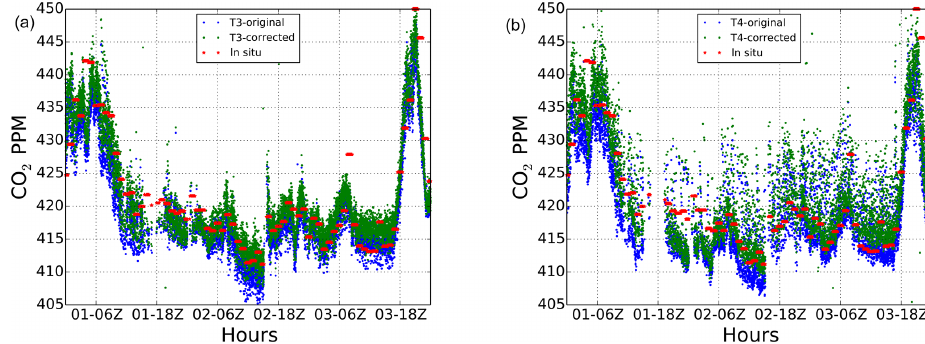
Figure 5. Sample set of 4d median post-processed retrieved GreenLITE ™ values and corresponding in situ observations for a representative 3d period in March 2016. The median values were computed every 6h using a 4d window over all chords for all transceiver–RT-model combinations. The blue data represent the uncorrected results for transceivers 3 (a) and 4 (b) , the green data illustrate the reprocessed data using LBLRTM 12.8 and line parameters based on HITRAN 2016 (HT-2016), and the red data show the average hourly in situ